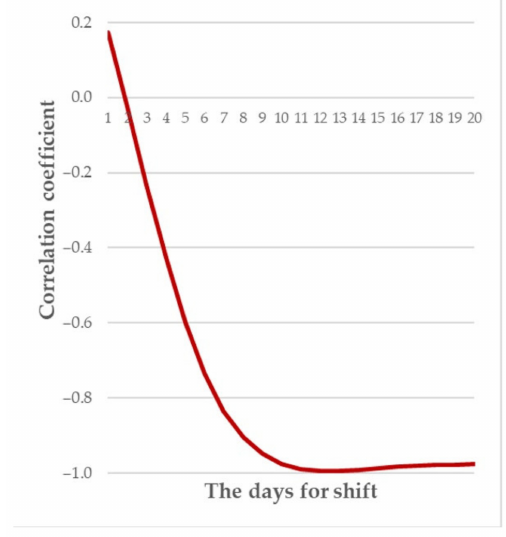
Figure 15. Correlations (vertical axis) between river discharge and groundwater level vs. selected days’ shift (horizontal